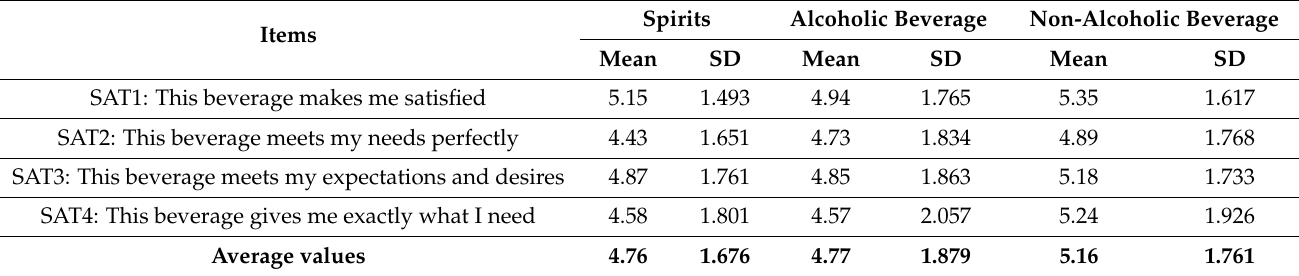
Table 4. Descriptive measures for